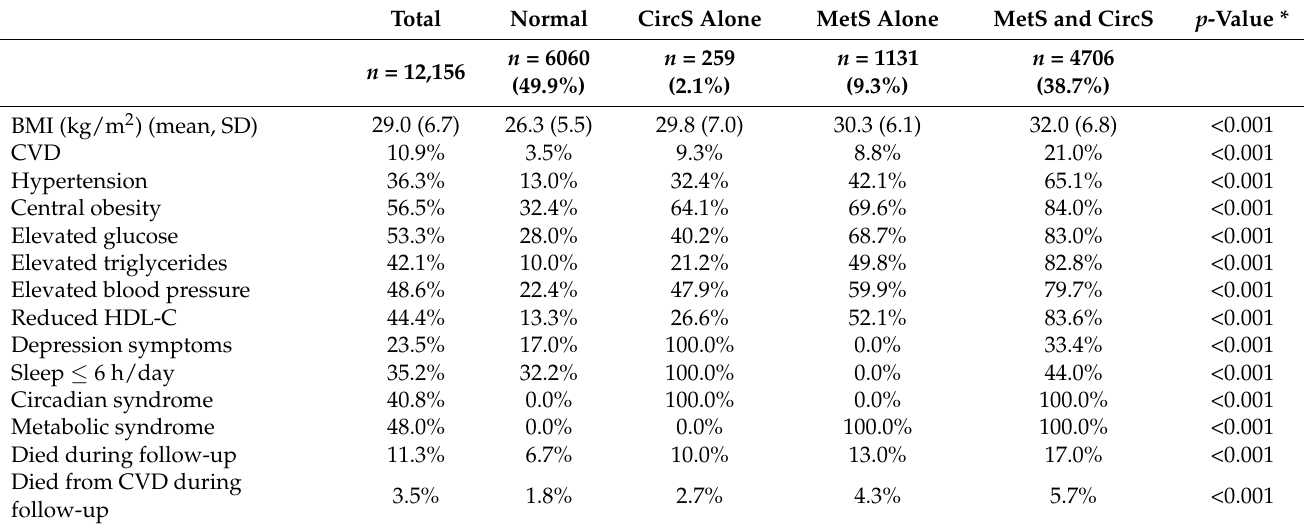
* p -values were 2 sided and generated from analysis of variance for continuous variables and chi-square for categorical variables. Abbreviations: BMI, body mass index; CVD, cardiovascular disease; CircS, circadian syndrome; MetS, metabolic syndrome; SD, standard deviation; METs, metabolic equivalent of tasks. Both MetS and CircS were associated with prevalent CVD. The unweighted preva- lence of CVD was 20.4% among people with the CircS and 18.7% in those with the MetS, respectively, in comparison to 3.5% in the normal group ( p < 0.001). In the fully adjusted multivariable logistic models for the CircS and MetS, the odds ratios (OR) for prevalent